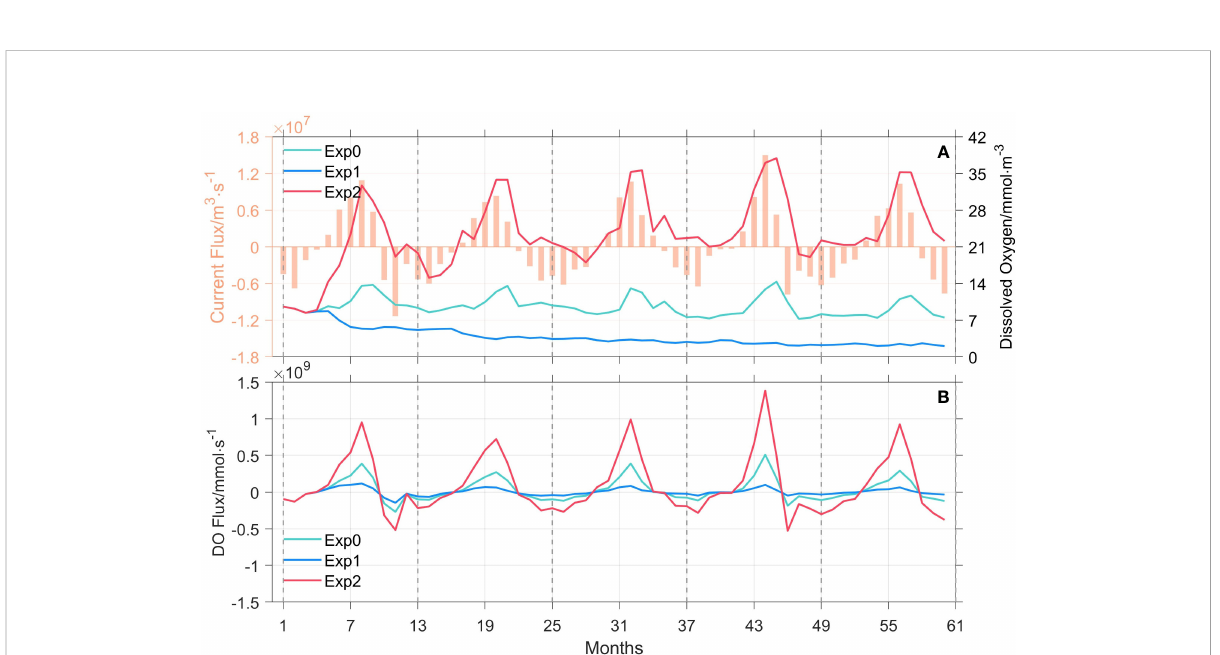
FIGURE 8 Current fl ux ( A , orange bar, left y -axis) and dissolved oxygen concentration ( A , line, right y -axis) near 11.8°N in the western side of the Arabian Sea (50° – 55°E). Associated dissolved oxygen fl ux (B) averaged between 200 and 1,000 m near 11.8°N in the western side of the Arabian Sea from three experiments (Exp0, Exp1, and Exp2).